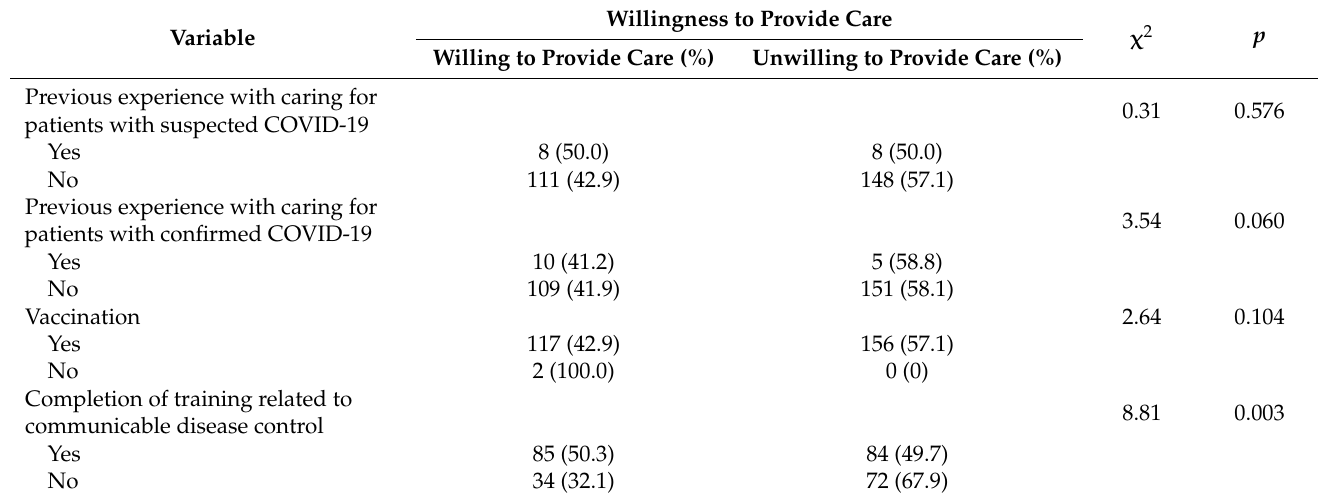
Table 4. Univariate analysis of relevant epidemic prevention (treatment and control) experience and willingness to provide care to patients with COVID-19 ( n =